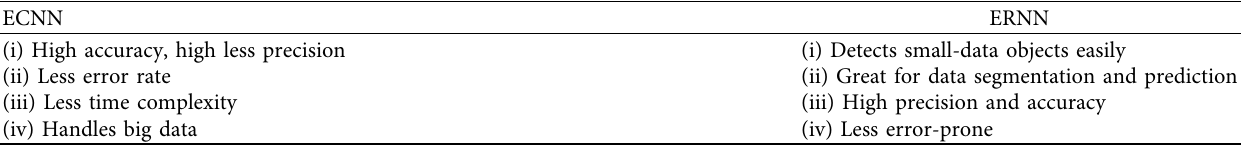
Table 5: Advantages of proposed ECNN and ERNN